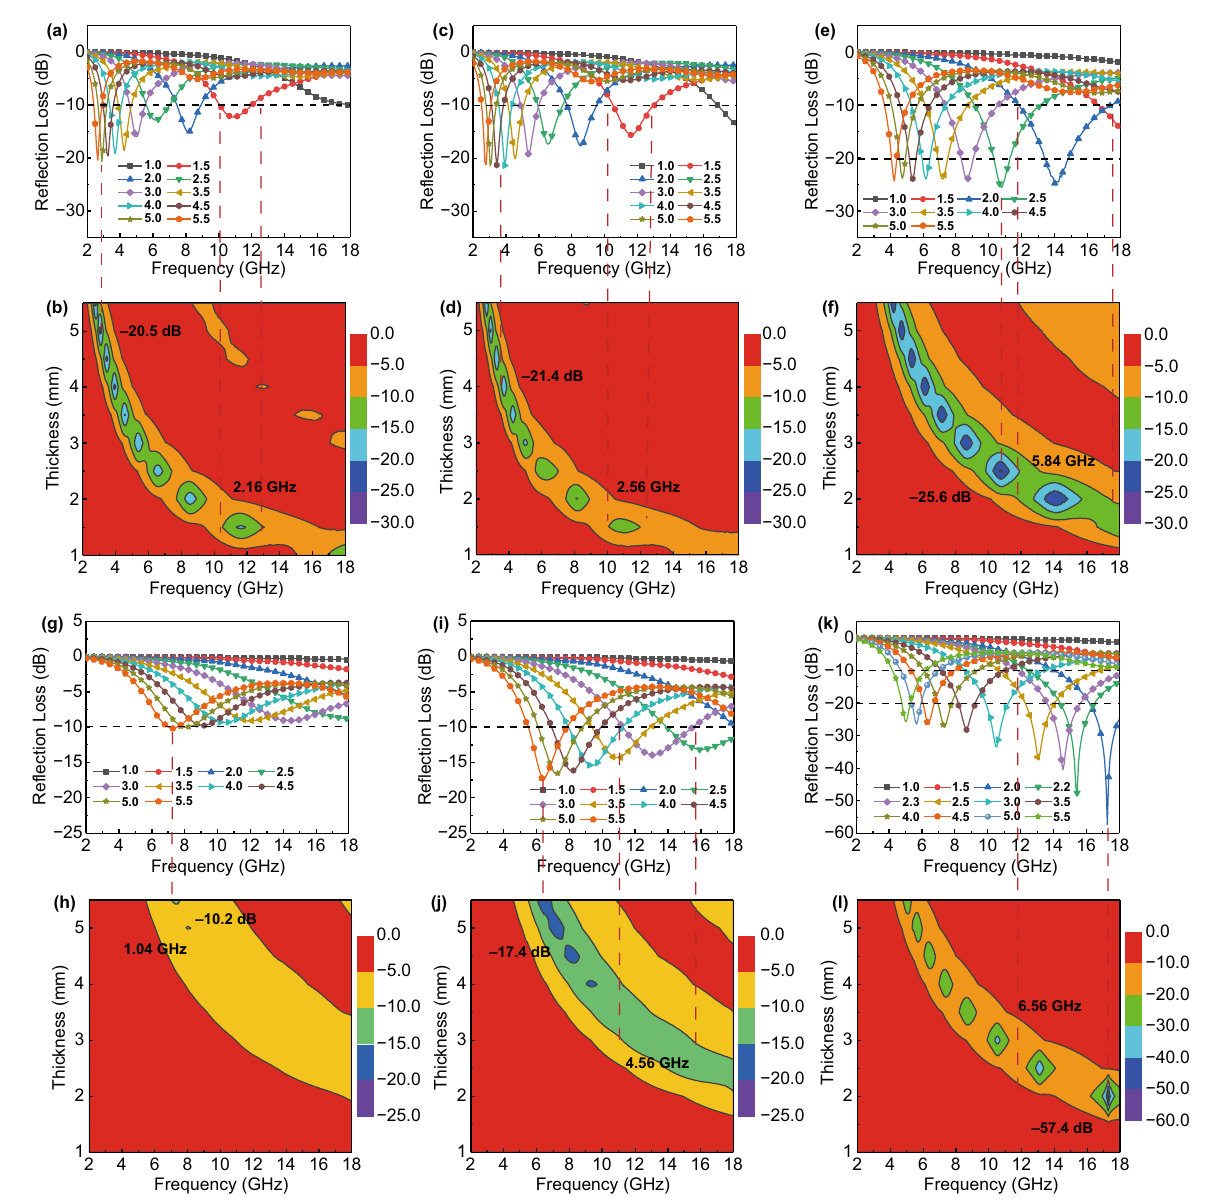
Fig. 3 Frequency dependence of reflection loss for Ti 3 C 2 T x hollow spheres and Ti 3 C 2 T x @ZnO hollow spheres: a , b Ti 3 C 2 T x ‑450, c , d